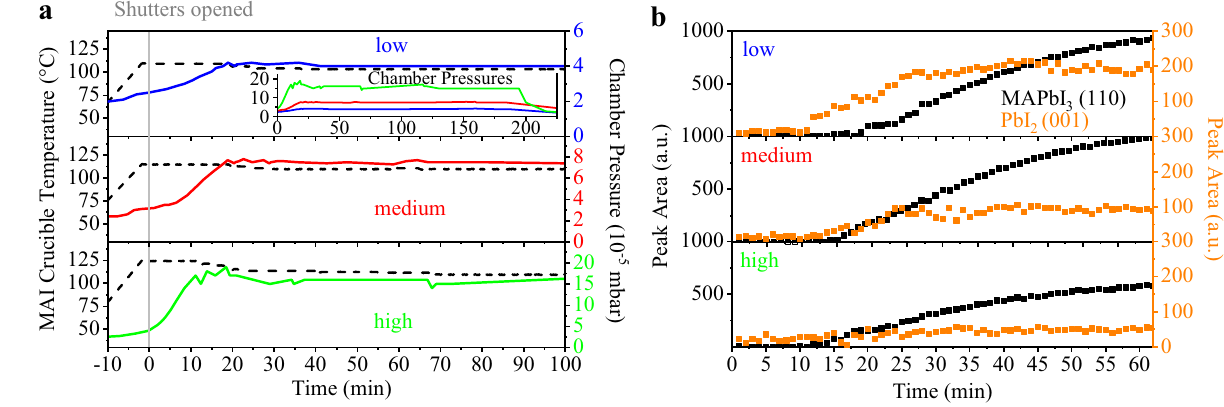
Figure 3. Characterizing initial growth while varying the chamber pressure: ( a ) MAI crucible temperature and chamber pressure during the first 100 min of each evaporation process. Inset: chamber pressure plotted for the whole duration of the processes for direct comparison. ( b ) Peak areas for MAPbI 3 (110) and PbI 2 (001) peaks for the ISXRD scans for the first 60 min of each evaporation process after opening the shutters.